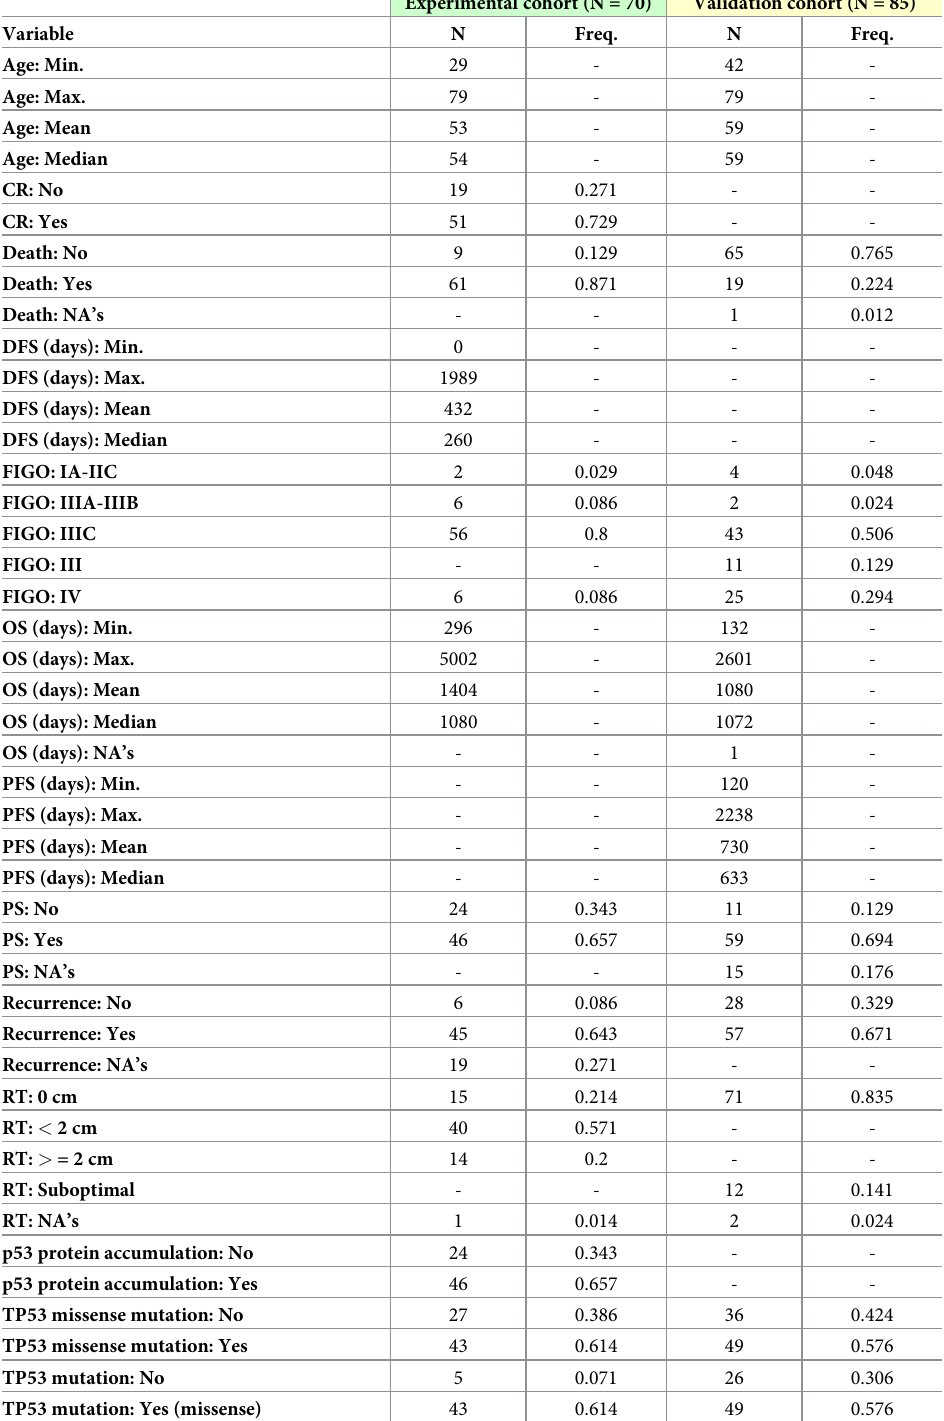
Table 4. Clinico-pathological characteristics of patients and tumors. Experimental cohort (N =